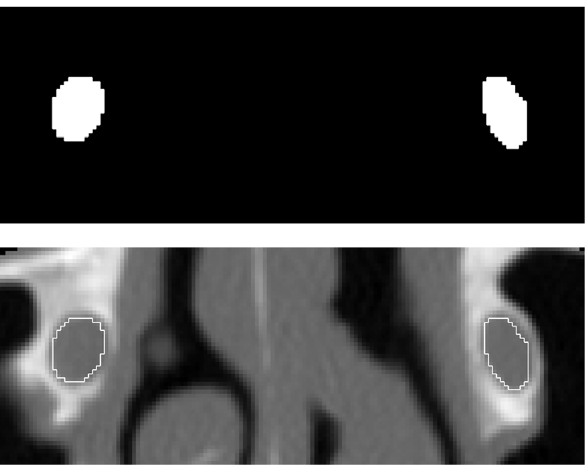
NLC superimposed to CT slice.